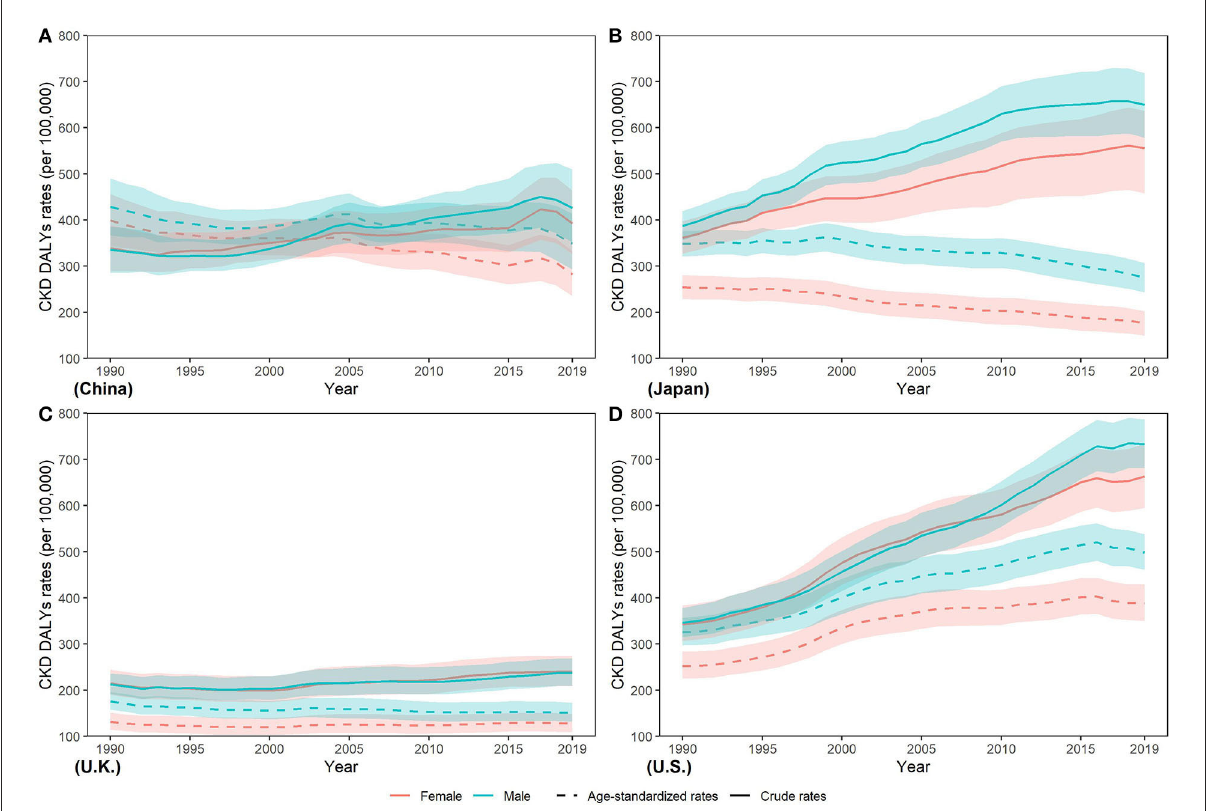
FIGURE6 Trends in CKD disability-adjusted life year rates from 1990 to 2019 in (A) China (B) Japan (C) U.K., and (D) the U.S.